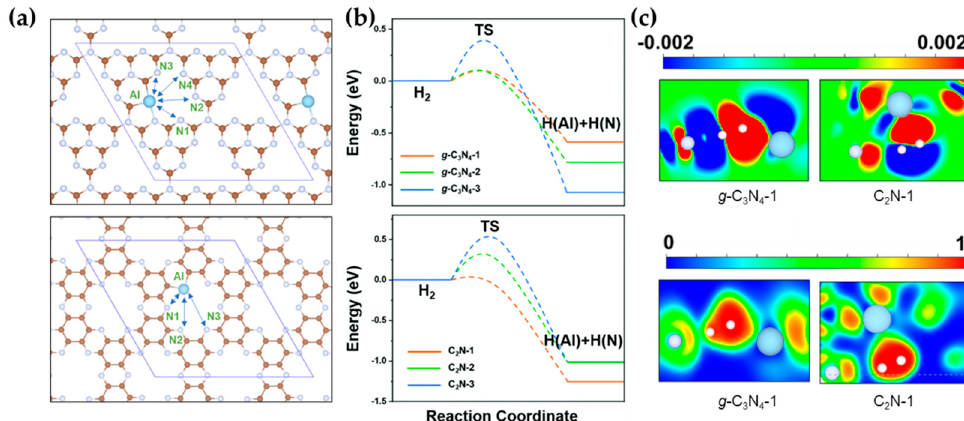
Figure 10. ( a ) Scheme of potential FLPs on Al-doped g -C 3 N 4 (upper) and C 2 N (bottom). ( b ) Energy profile of H 2 activation on Al/N FLPs. Based on PBE-D2 via VASP. ( c ) CDD (upper) and ELF (bottom) maps for TSs of H 2 activation on g -C 3 N 4 -1 and C 2 N-1. Adapted from reference [55] with permission.